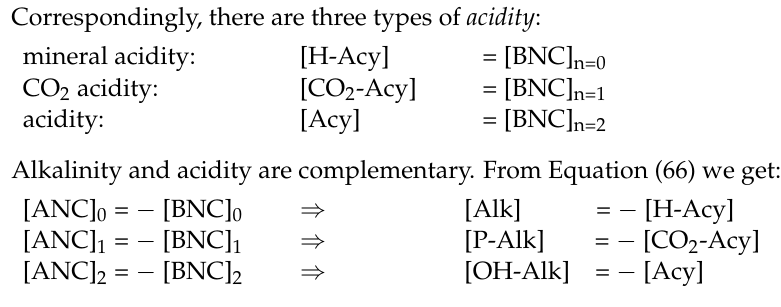
Figure 30. Titration curve n = n(pH) for carbonic acid (C T = 10 mM) with equivalence points and the corresponding types of alkalinity and acidity.